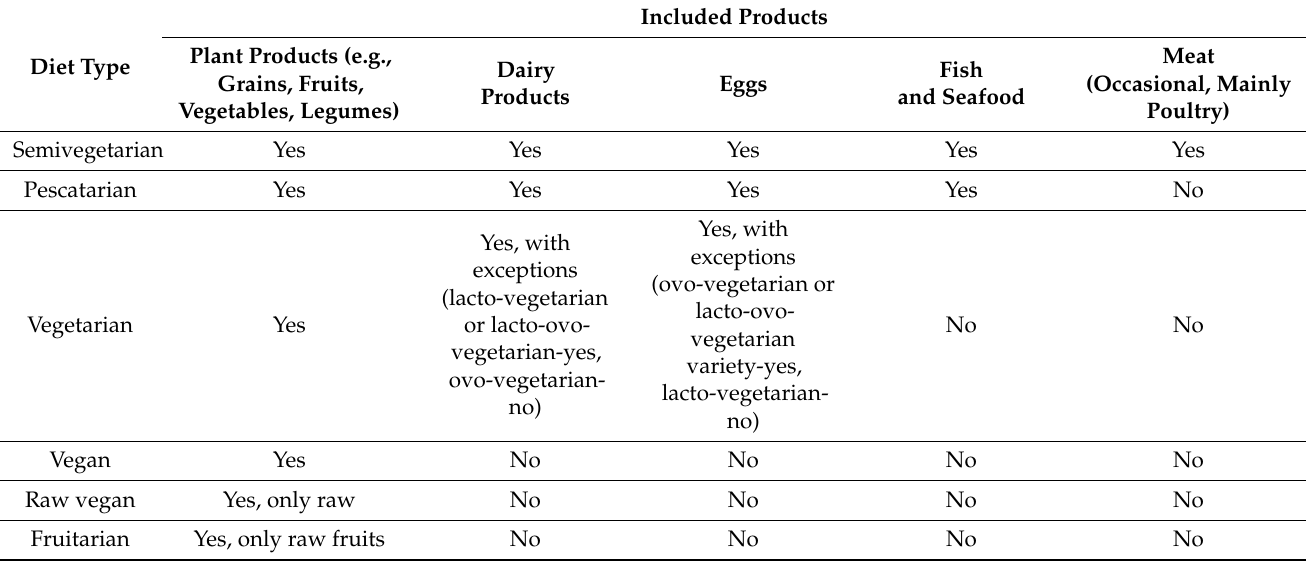
Table 2. Types of vegetarian diets with their characteristics and eliminated